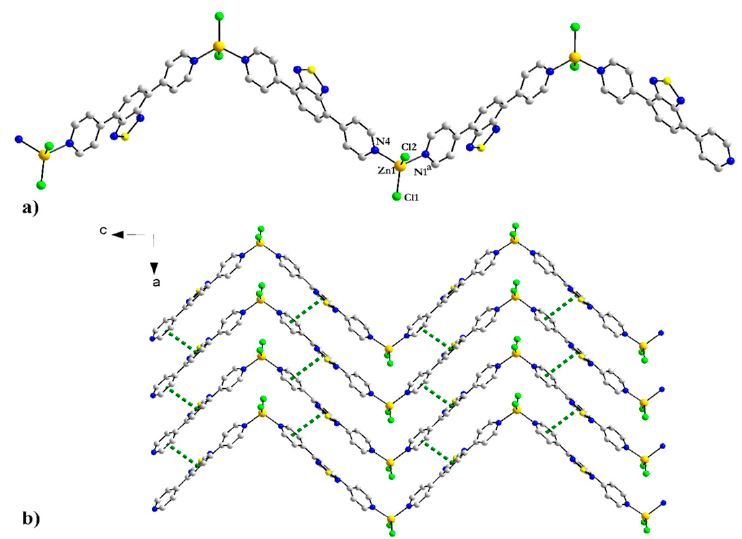
Figure 7. ( a ) Structural detail of a zig-zag chain in compound 9 ; ( b ) Supramolecular layer from π – π